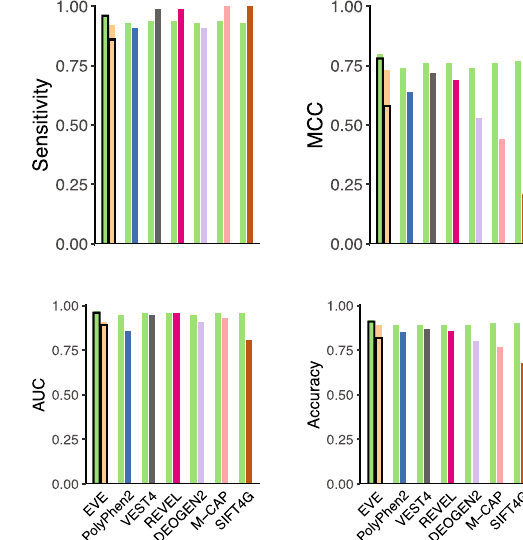
withEVEonits73%variantscoverage(thinblackbordersquare).ForEVEthereare2 comparisons: the fi rst (bars without black border) indicate the performance when uncertain class variants are excluded and the bars with black borders include the uncertain variants as well. We assigned their class as if EVE was a random classi fi er (Table1).WhilealltoolsreachalmostperfectROC-AUCandsensitivity,DeMAGhas the most balanced performance, namely the highest MCC (top right panel). For con fi dence intervals calculated on 1000 bootstrap samples refer to Supplemen- tary Fig. 14.